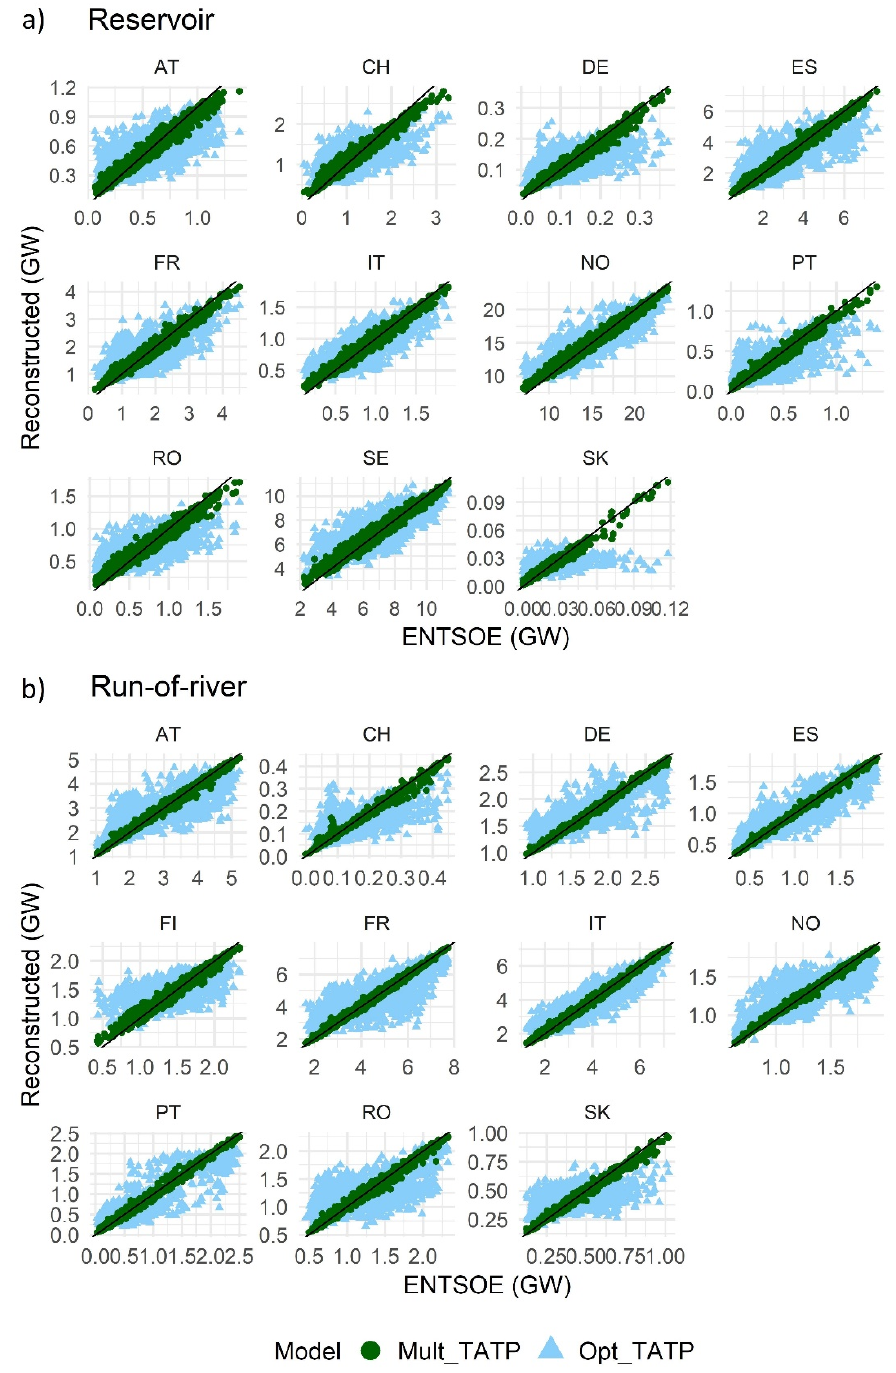
Figure 3. Scatter plots of hydro power generation for reservoir-based ( a ) and run-of-river ( b ) generation comparing ENTSO-E data on the x-axis and model reconstructed values on the y-axis for models (2) and (4): multiple lags of temperature and precipitation (green dots) and optimal lag (blue dots). In general, the multiple lags approach (Mult_TATP) performs better with less deviation and gives a larger improvement for run-of-river generation, while the optimal lag model (Opt_TATP) has a larger bias for extreme